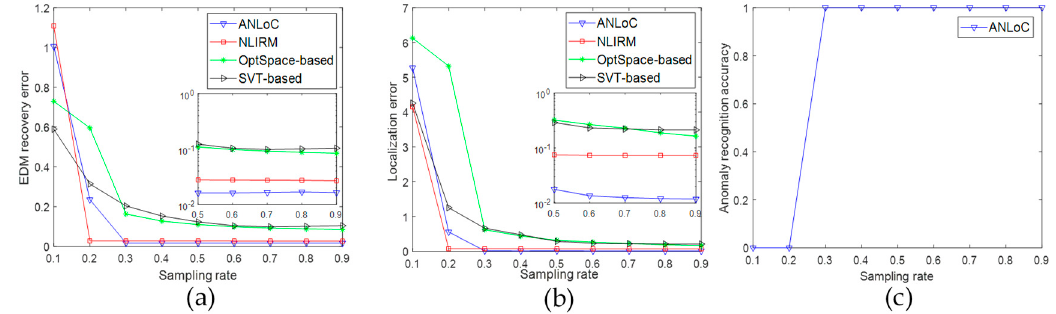
Figure 6. Performance comparison under scenario 4 with both complex noise and anomaly. ( a ) EDM recovery error; ( b ) localization error; and ( c ) anomaly recognition accuracy.